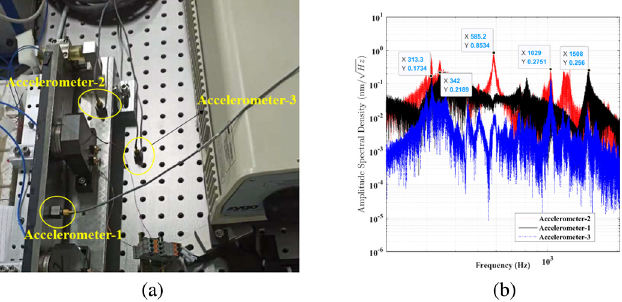
Fig. 12. Analysis of controlled objects by accelerometers: (a) experiment setup; (b) spectrogram of the